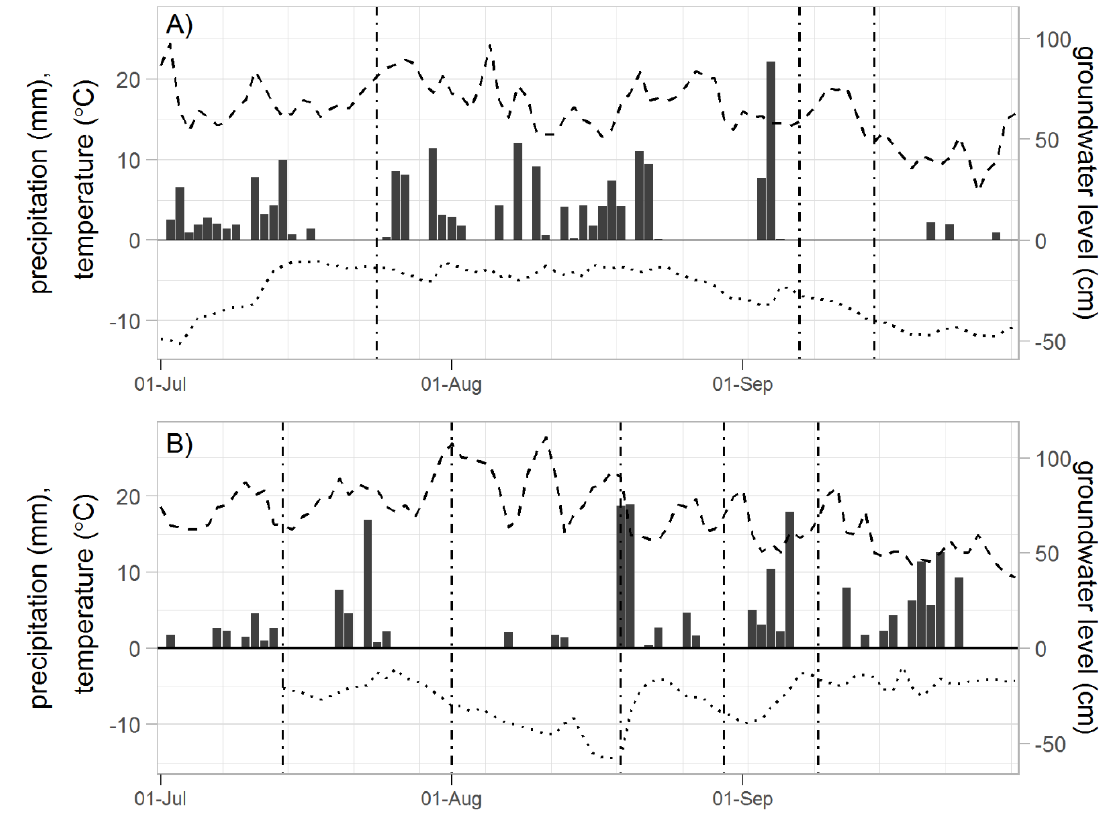
Figure 6. Precipitation (black bars), temperature (dashed lines), and groundwater level (dotted lines) for ( A ) the Biebrza National Park and ( B ) the Janów Forest Landscape Park. Vertical dash-dotted lines indicate UAS flight campaigns (Table 1).